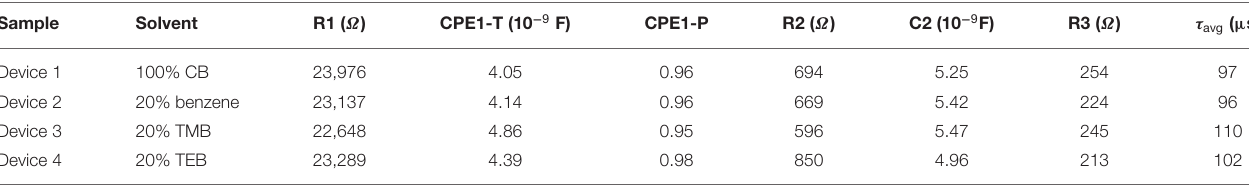
TABLE 2 | Calculation result of equivalent circuit parameters from the fitted impedance spectrum.